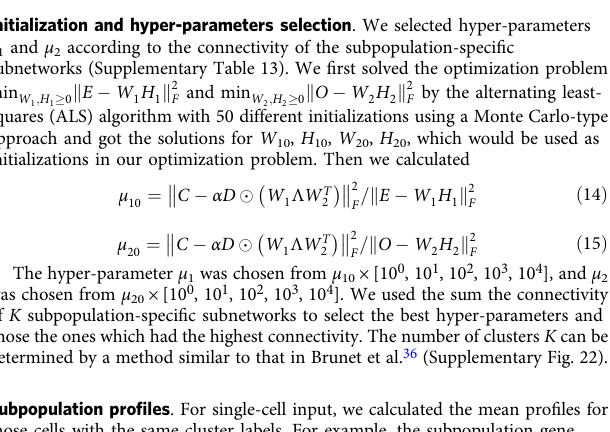
Surface markers selection . To sort the subpopulation 2 cells, we selected sub- population 2 speci fi c surface markers from gene expression data. We required that the selected surface markers satisfy the following conditions: (i) Differentially expressed between subpopulation 2 and the other subpopulations. (ii) Highly expressed in subpopulation 2, and (iii) expression level in subpopulations 1 and 3 are less than 2. In practice, we compared the distribution of surface markers ’ expression in subpopulation 2 versus the other subpopulations by t -test. We selected the top 20 markers and further require that TPM expression in sub- population 2 be greater than 10 and higher than in subpopulations 1 and